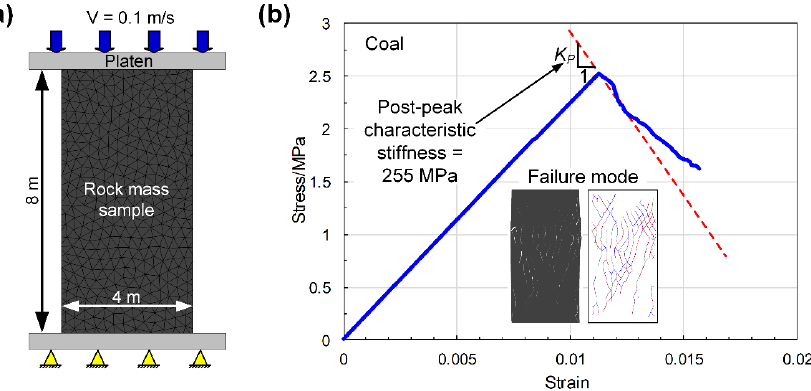
Figure 6. ( a ) Concept of the REV (after Bear, [49]). ( b ) The effect of sample size on the strength of coal (after Bieniawski, [50]).